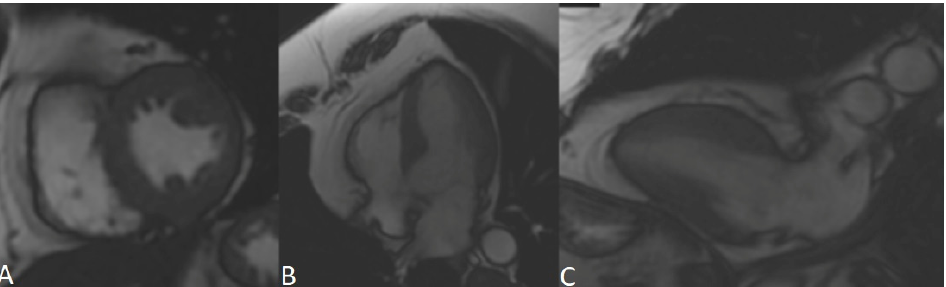
Figure 7. Electrocardiogram patient III.13. Sinus base rhythm T negative V1–V2 and flattened V3.